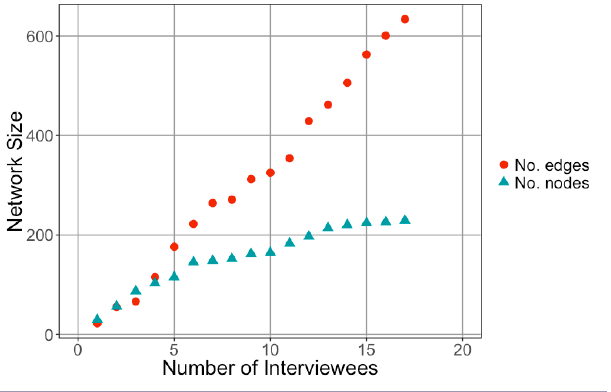
Fig. 2 . Total number of new ecosystem components (nodes) and relationships (edges) contributed by